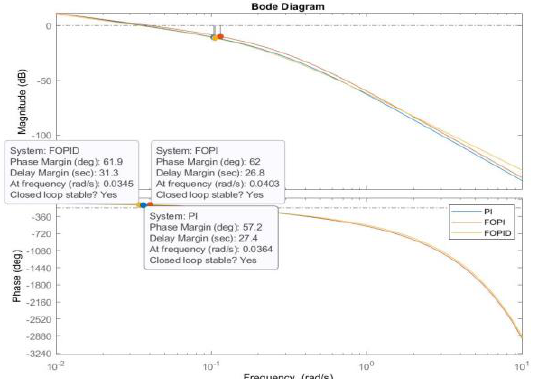
Figure 16. Bode diagrams of the open-loop system for the integer-order PI, FO-PI, and FO-PID controllers in the case of +2% process changes.